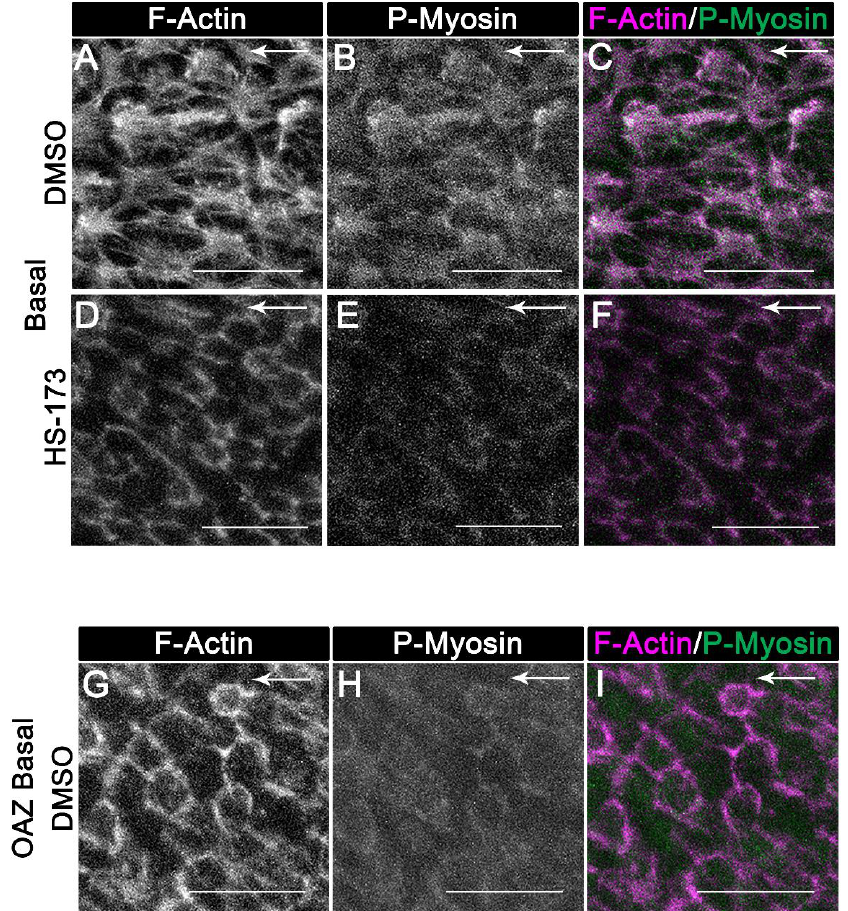
Figure 6. Role for p110 α in regulating reorganization of actomyosin along the basal surface of the lens epithelial follower cells for wound healing. ( A – G ) Ex vivo post-cataract surgery explants were treated with vehicle control or HS- 173 to inhibit p110α from Time 0 for 24 h (Day 1 post-injury). Cultures were labeled with phalloidin to identify filamentous actin (F-actin, white ( A , D , H ), purple ( C , F , J )) and immunolabeled for active myosin II (P-myosin, white ( B , E , I ), green ( C , F , J )). Confocal images along the basal surface of the wounded lens epithelium revealed that ( A – C ) normal basal actomyosin reorganization into stress fibers within wounded epithelial cells is blocked with ( D – F ) HS-173 treatment. ( H – J ) Confocal images along the basal surface of the wounded epithelial cell located in the OAZ are shown for comparison to HS-173 treated cells ( D – F ) revealing a similarity in basal actomyosin organization of HS-173 basal follower cells to nonmoving wounded epithelial cells in the OAZ. Magnification bars = 20 μ m and arrows show direction of cell migration ( A – I ). 3.4. p110α Is Required for Epithelial Cell Proliferation in Response to Wounding In the lens, p110α function has previously been linked to regulating lens epithelial cell proliferation during lens development [33]. Since wound healing typically requires both collective migration and proliferation for wound closure, we next determined whether p110α may also regulate proliferation in response to wounding. Ex vivo post - cataract surgery cultures were treated with vehicle or HS-173 on day 0 and EdU labeled for 30 min on day 1 post-treatment. Cultures were counterstained with DAPI to identify nuclei and imaged at the wound edge of the CMZ. Treatment with HS-173 resulted in a